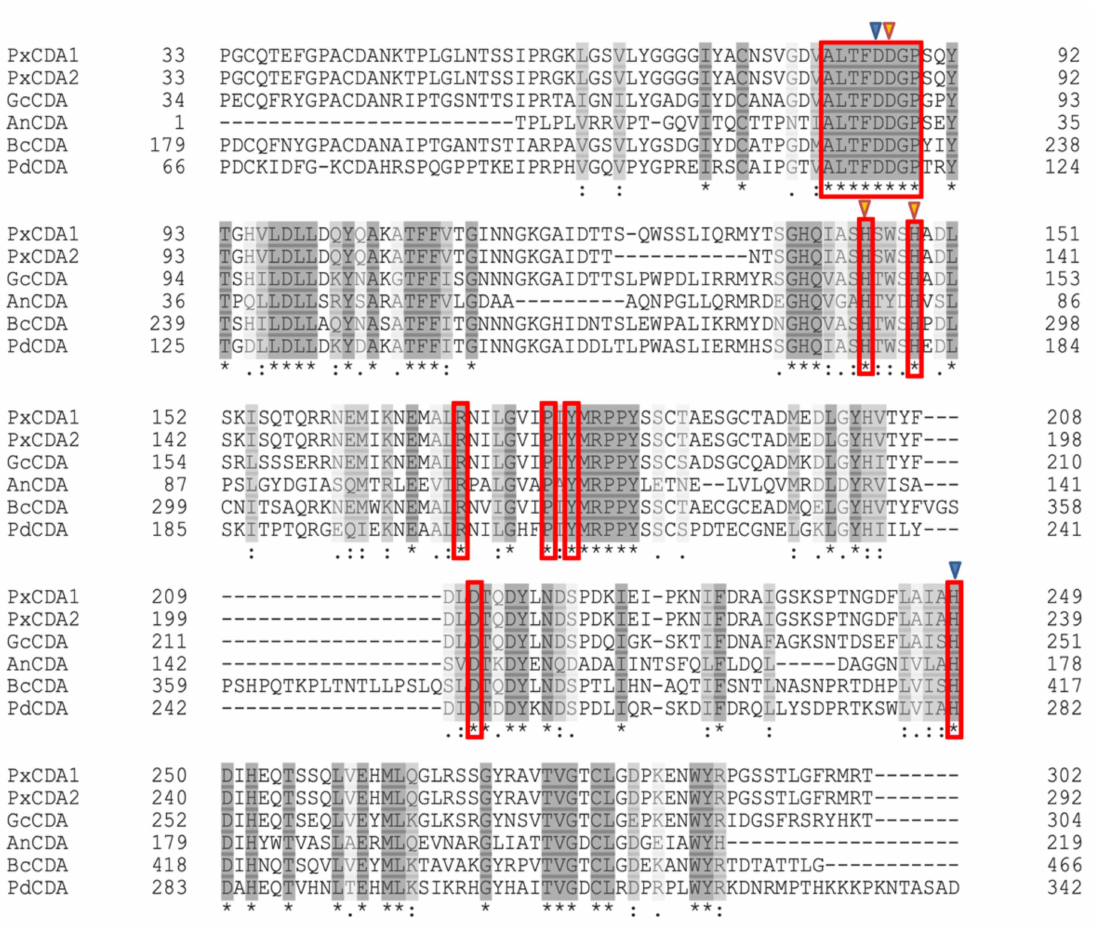
Figure 1. Amino acid sequence alignment of mature chitin deacetylases from P. xanthii and chitin deacetylases from various fungi. PxCDA1 ( P. xanthii , KX495502), PxCDA2 ( P. xanthii , KX495503), GcCDA ( Golovynomices cichoracearum , RKF73335), AnCDA ( A. nidulans , EAA66447), BcCDA ( B. cinerea , CCD52127), and PcCDA ( P. digitatum , XP_014535670). The amino acid similarity is shown in grey, with the darkest grey amino acids being the most similar. Conserved amino acids are marked with an asterisk. Conserved residues that are important for enzyme activity are shown in red boxes. The orange arrows show the amino acids involved in iron binding. The blue arrows show the residues that are part of the catalytic site. The sequences were aligned using UniProt web